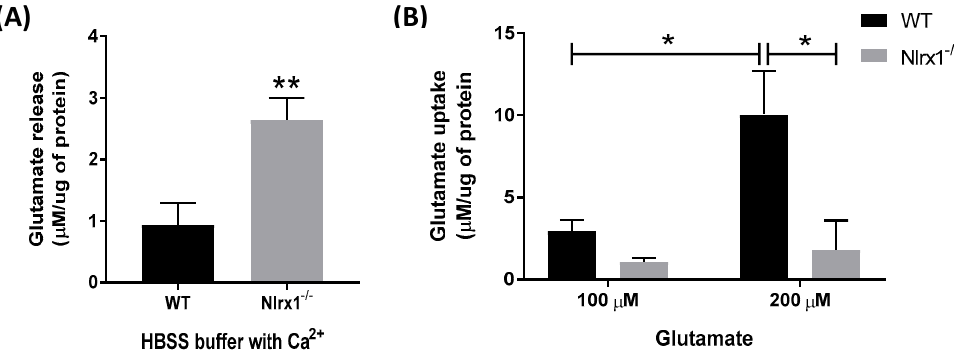
Figure 1. NLRX1 inhibits glutamate release and enhances glutamate uptake by astrocytes. ( A ) WT and Nlrx1 - / - astrocyte cultures were incubated in glutamate-free, Ca 2 + -containing HBSS medium. After 4